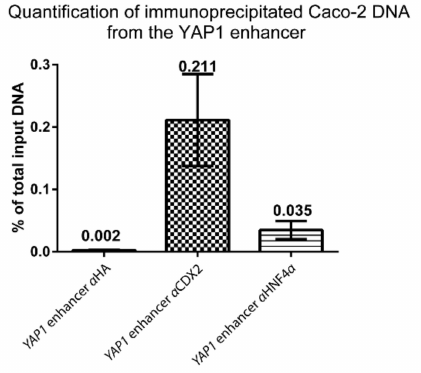
Figure 6. PCR quantification of Caco-2 DNA immunoprecipitated with either anti-CDX2 ( α CDX2) or anti-HNF4 α ( α HNF4 α ) or control anti-hemagglutinin ( α HA) antibodies. The amount of purified Caco-2 ChIP DNA was compared to the amount of input DNA (non-immunoprecipitated) in the YAP1 + 82 kb enhancer, using specific primers (Table S2-B). Quantification was performed by ChIP-qPCR and bars represent mean values with range, n =